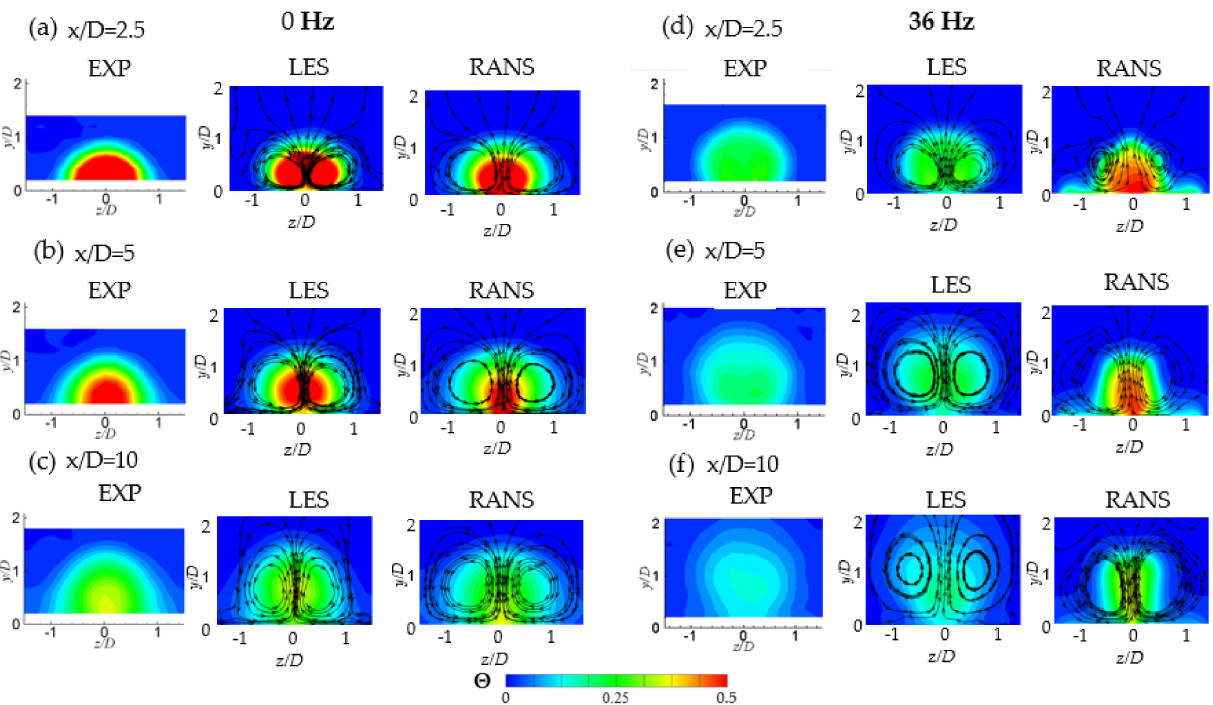
Figure 8. Time-averaged dimensionless temperature contours and streamlines for the orientation angle of 0 ◦ on the plane of x/D = 2.5, 5, and 10 at steady state (0 Hz) and 36 Hz